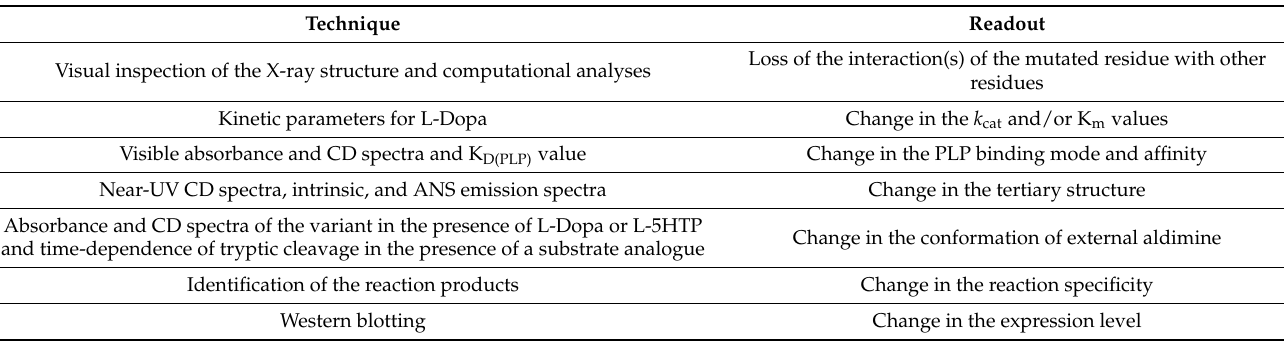
Table 1. Technique and readout.